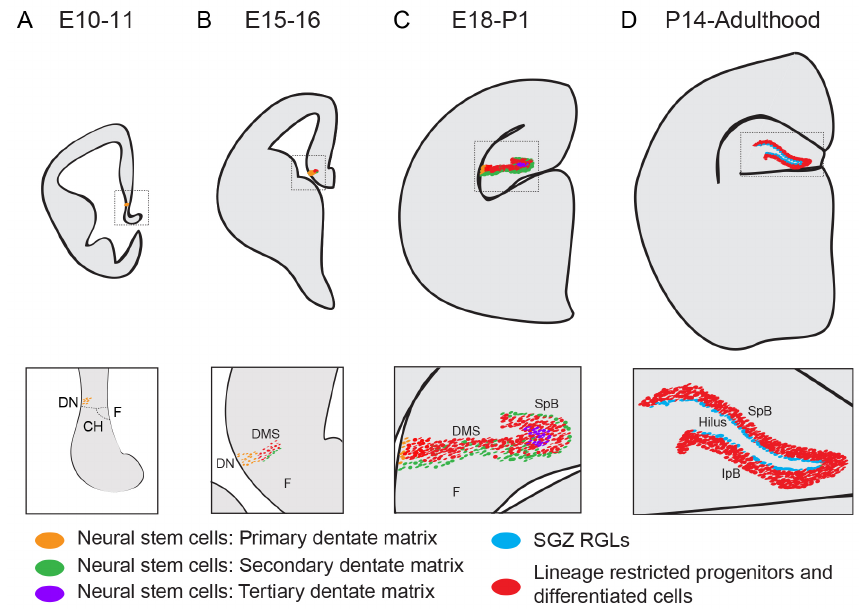
Figure 3. Development of the dentate gyrus. ( A ) Around embryonic day 10–11 (E10–11), the putative dentate neuroepithelium is situated adjacent to the dentate notch (DN), a small indentation of the ventromedial ventricular wall, which in turn is placed caudal to the cortical hem (CH), neighboring the fimbria (F). These neural stem cells (NSCs) are sometimes referred to as the primary dentate matrix. ( B ) During embryonic neurogenesis (E15–16), a stream of neural progenitors appears medial to the DN forming the dentate migratory stream (DMS). The DMS consists of both lineage-restricted neural progenitor cells (Tbr2 + ) and NSCs (expressing Sox2, Nestin, and GFAP). The DMS leads to the dentate primordium. ( C ) At about E18, the upper blade of the dentate gyrus (also called the suprapyramidal blade, or SpB) starts to form and contains post-mitotic Prox1 + neurons, as well as a layer of NSCs that are located subpially, on the upper part of the SpB blade. These NSCs are defined as the secondary dentate matrix, and the NSCs ventral to the SpB are termed the tertiary dentate matrix. ( D ) At about postnatal day 14 (P14), both the SpB and the infrapyramidal blade (IpB) have formed. At this stage, the secondary and tertiary matrices are gone, and the remaining NSCs—now referred to as radial glia-like cells (RGLs)—are located in the subgranular zone (SGZ), on the border between the granule cell layer and the hilus. This structure and morphology are maintained throughout the rest of the animal’s